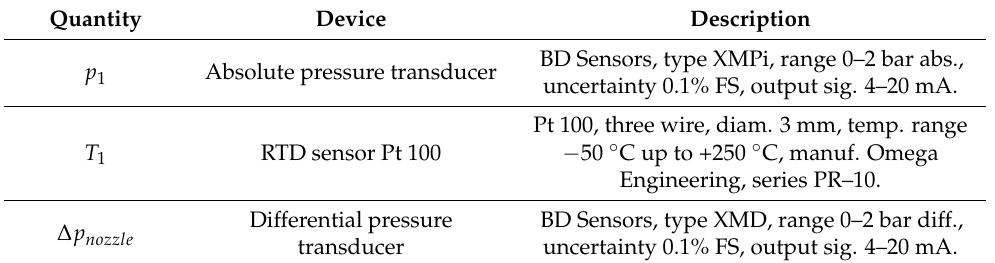
Table 1. Quantities measured on the aerodynamic track and related equipment.